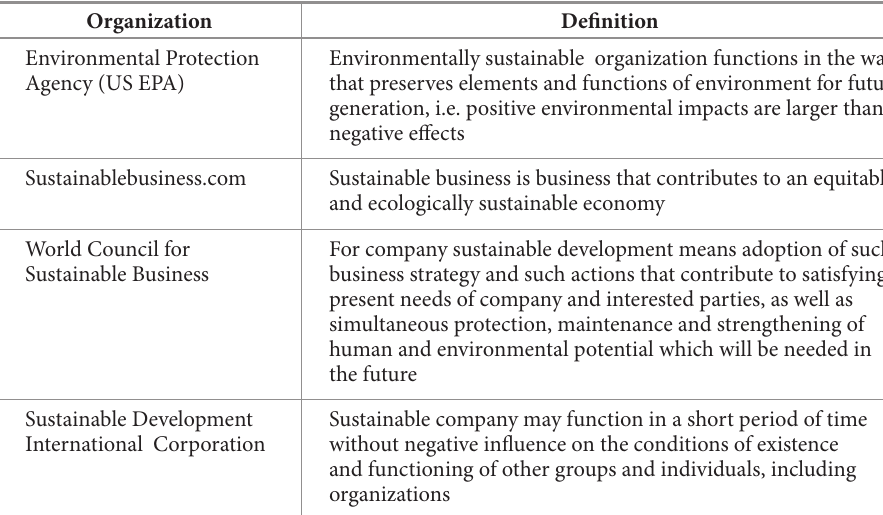
Table 1. Definition of sustainable